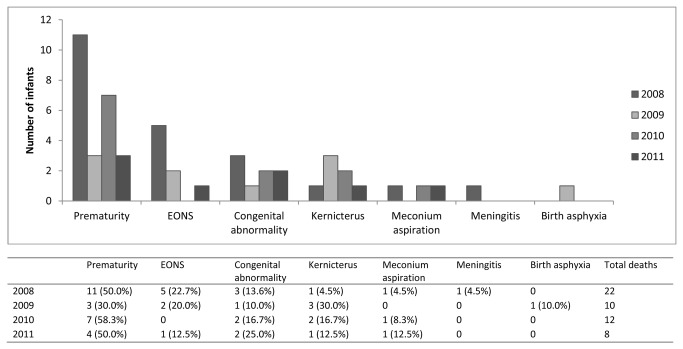
The main cause of death of infants addmited to SCBU.